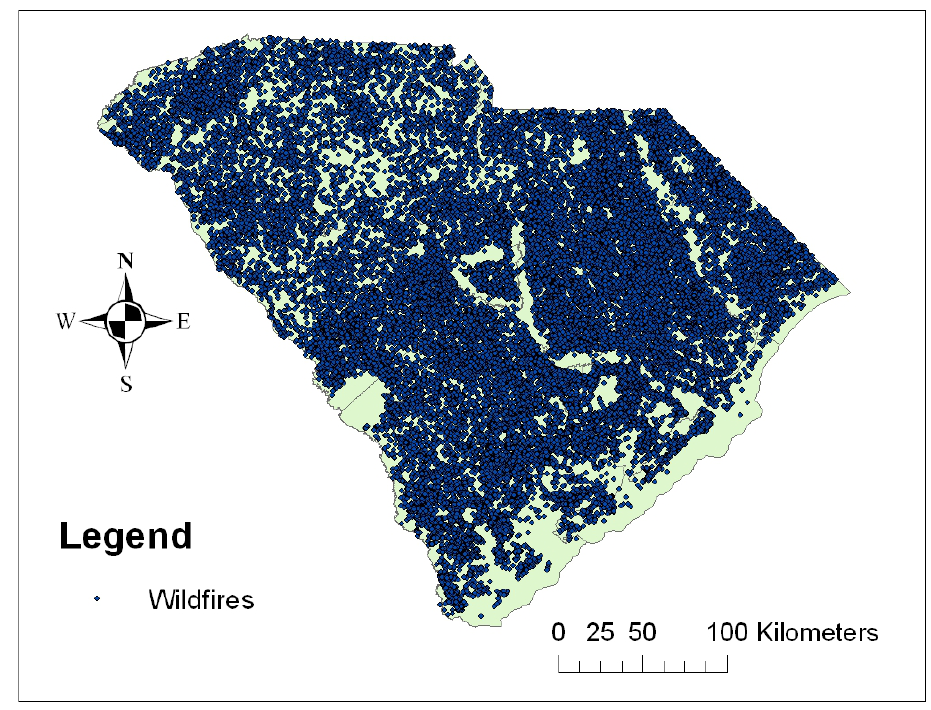
Figure 1. All wildfires from July 1997 until June 2011.